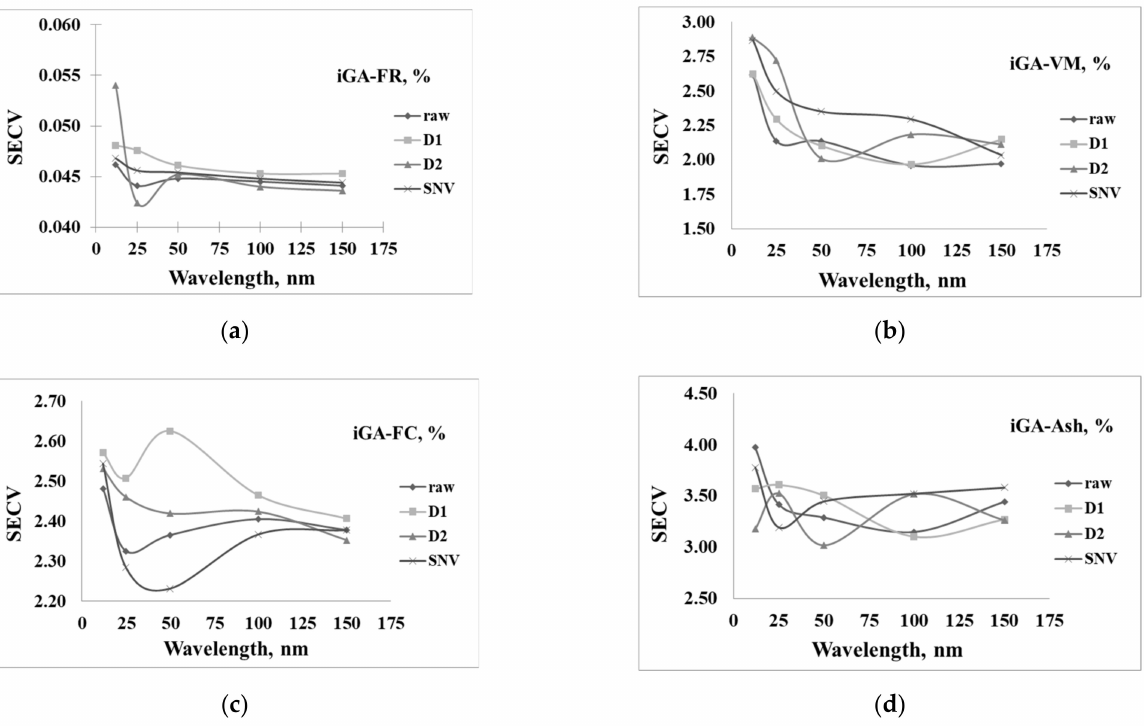
Figure 7. Wavelengths selected by iGA for 12, 25, 50, 100, and 150 wavelengths in prediction of ( a ) fuel ratio (FR, %), ( b ) volatile matter (VM, %), ( c ) fixed carbon (FC, %), and ( d ) ash content (A,